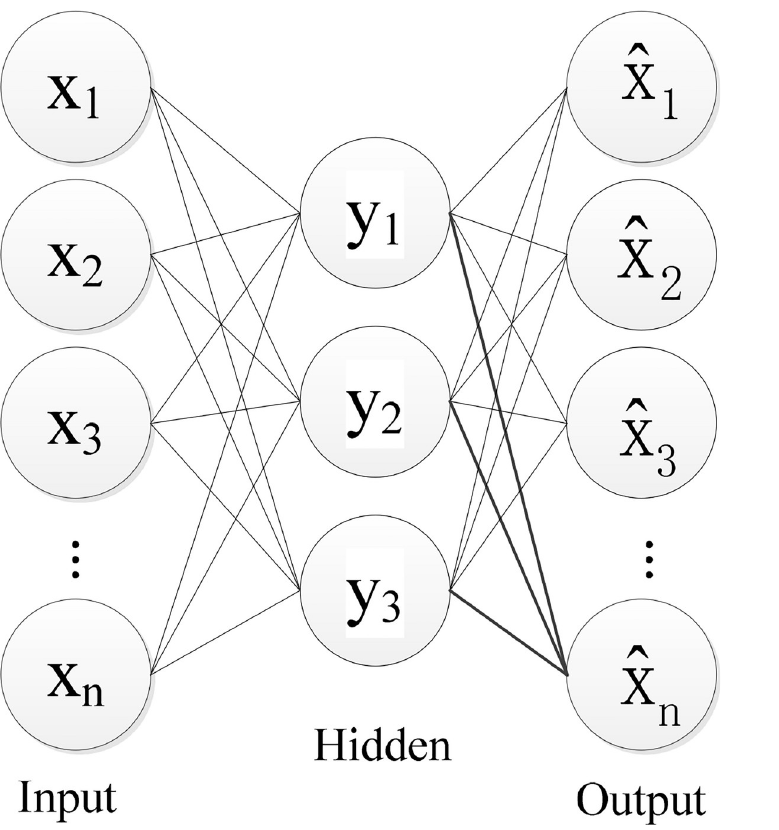
Fig 2. Schematic diagram of AE